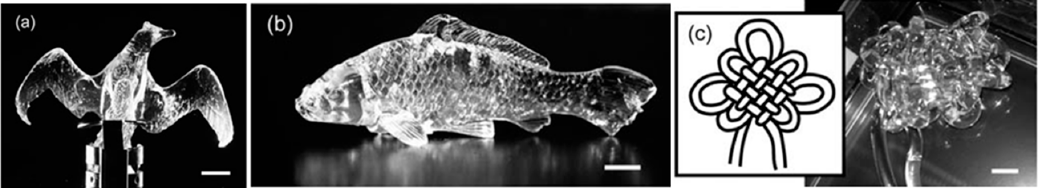
Figure 9. Pictures for the PVA/PAMPS/PAAm triple-network (TN) hydrogels with the shape of a ( a ) bird, ( b ) fish, and ( c ) Chinese knot. Scale bars: 1 cm. PVA: poly(vinyl alcohol); PAMPS: poly(2-acrylamido-2-methylpropane sulfonic acid); PAAm: polyacrylamide. Adapted and reprinted with permission from [23]. Copyright 2010 Royal Society of